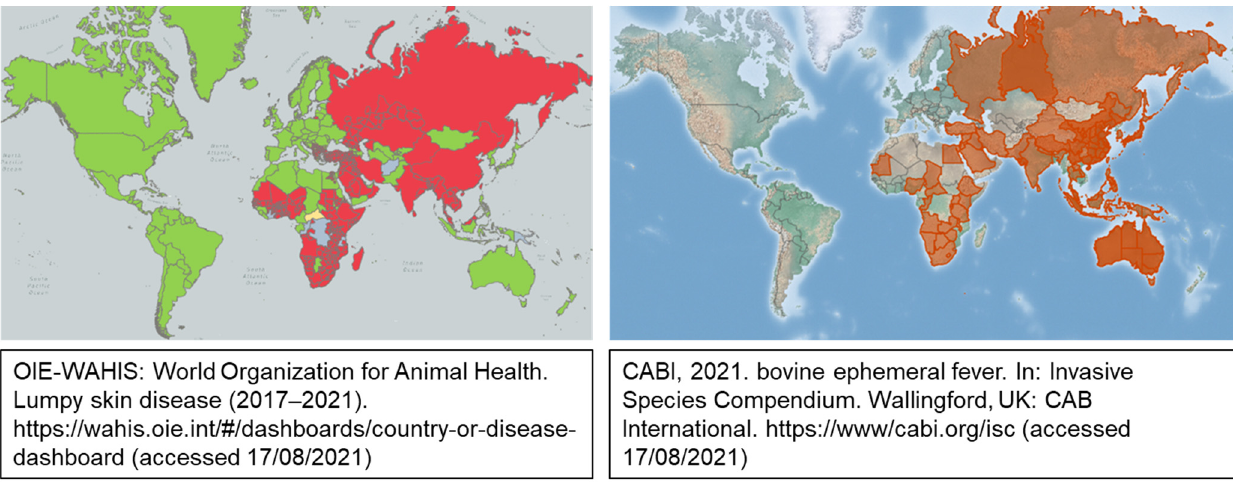
Figure 1. Geographical distribution of LSDV and BEFV. LSDV information was obtained from the OIE-WAHIS World Organization for Animal Health. LSD disease status is represented as: red—present, yellow—suspected, green—absent, grey—no information available. BEFV information was obtained from CABI.